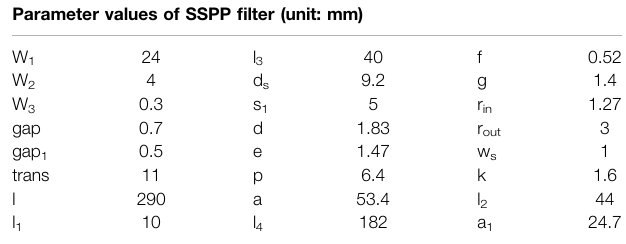
TABLE 4 | Parameter values of SSPP fi